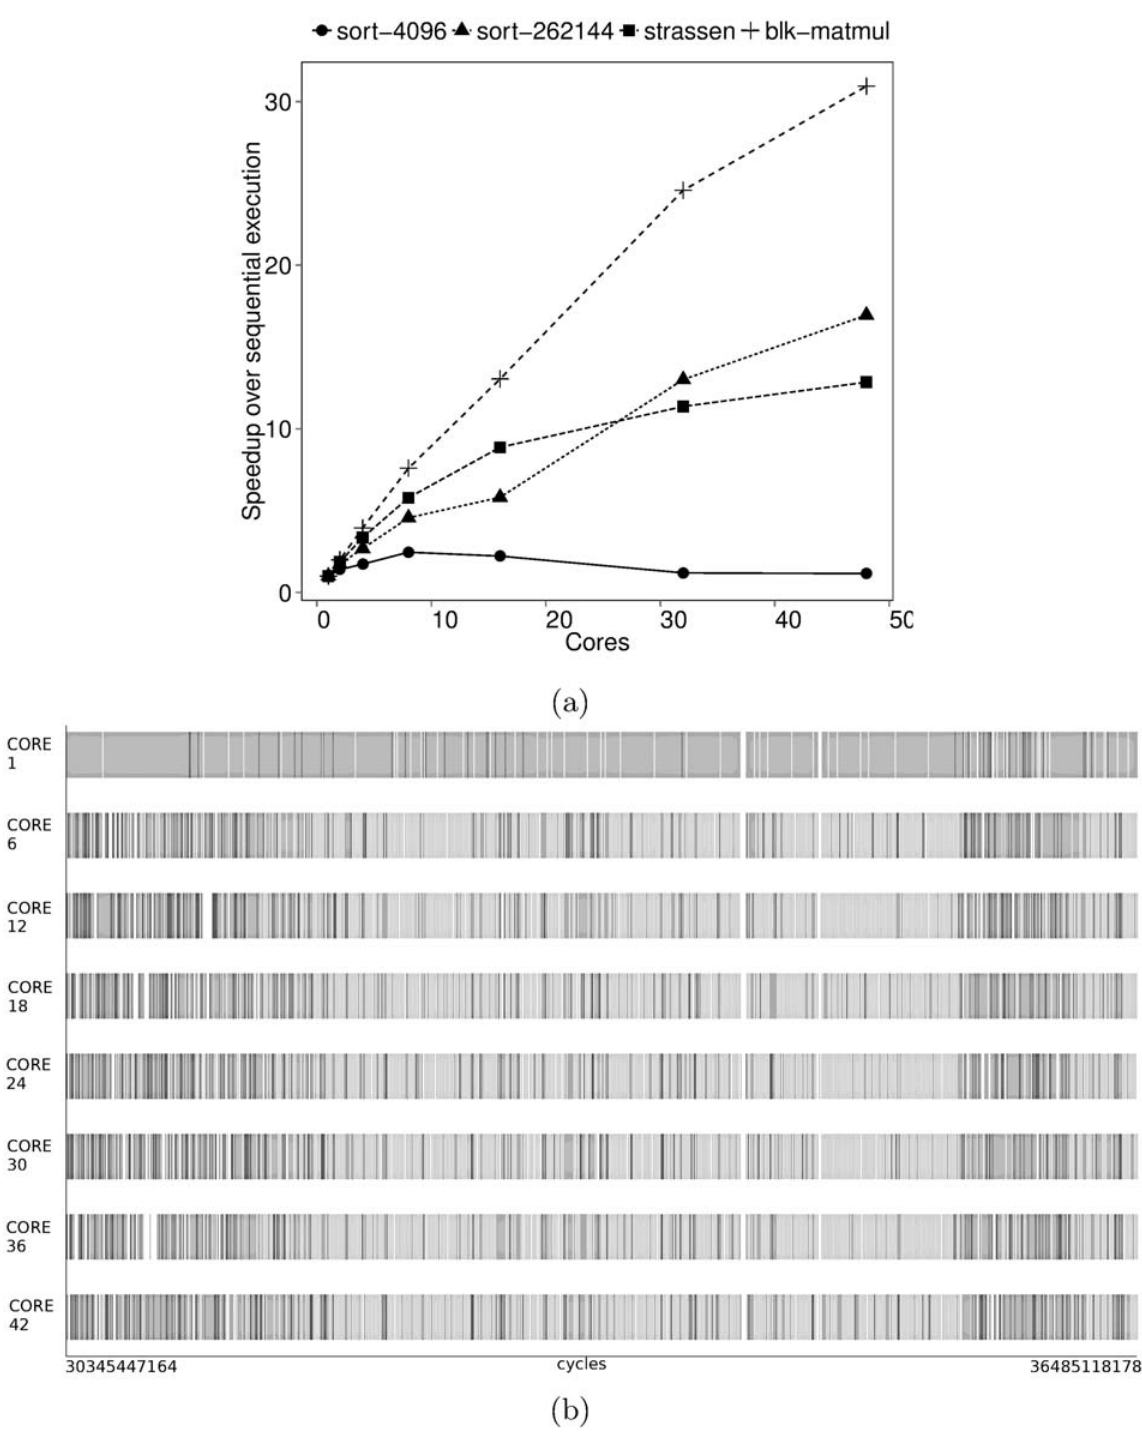
Fig 9. Diagnosing performance problems using thread-based performance metrics in BOTS Sort and Strassen. Sort input: array size = 64M elements, quicksort cutoff = {4096 (default), 262144}, sequential merge sort cutoff same as quicksort cutoff, insertion sort cutoff = 128. Strassen input: dimension = 4096, cutoff = 128 (default). Blocked matrix multiplication (blk-matmul) input: dimension = 4096, block size = 128. Executed on all cores of 48-core AMD Opteron 6172 machine running at highest frequency with frequency scaling turned off. (a) Speedup (b) Visualization of state traces from 6/48 threads executing Sort with default cutoffs. White bars indicate task creation, black bars, task execution and gray bars, task synchronization. The six threads are bound to cores on different dies.